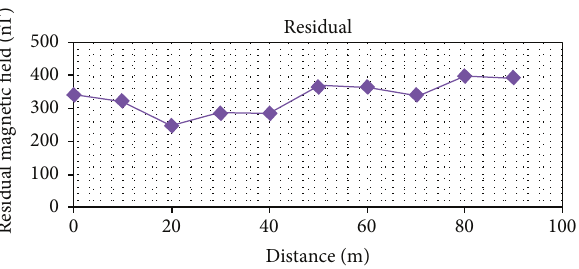
Figure 9: Profile 4.